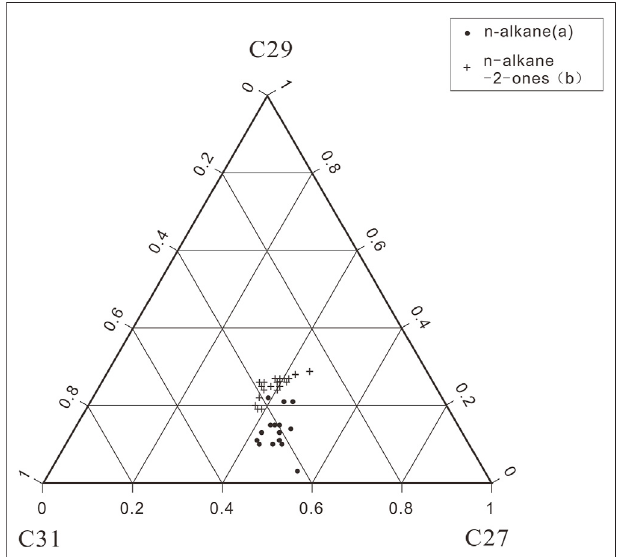
FIGURE 7| Ternary diagram for C 27 , C 29 and C 31 n -alkaneand n -alkan- 2-one in the studied